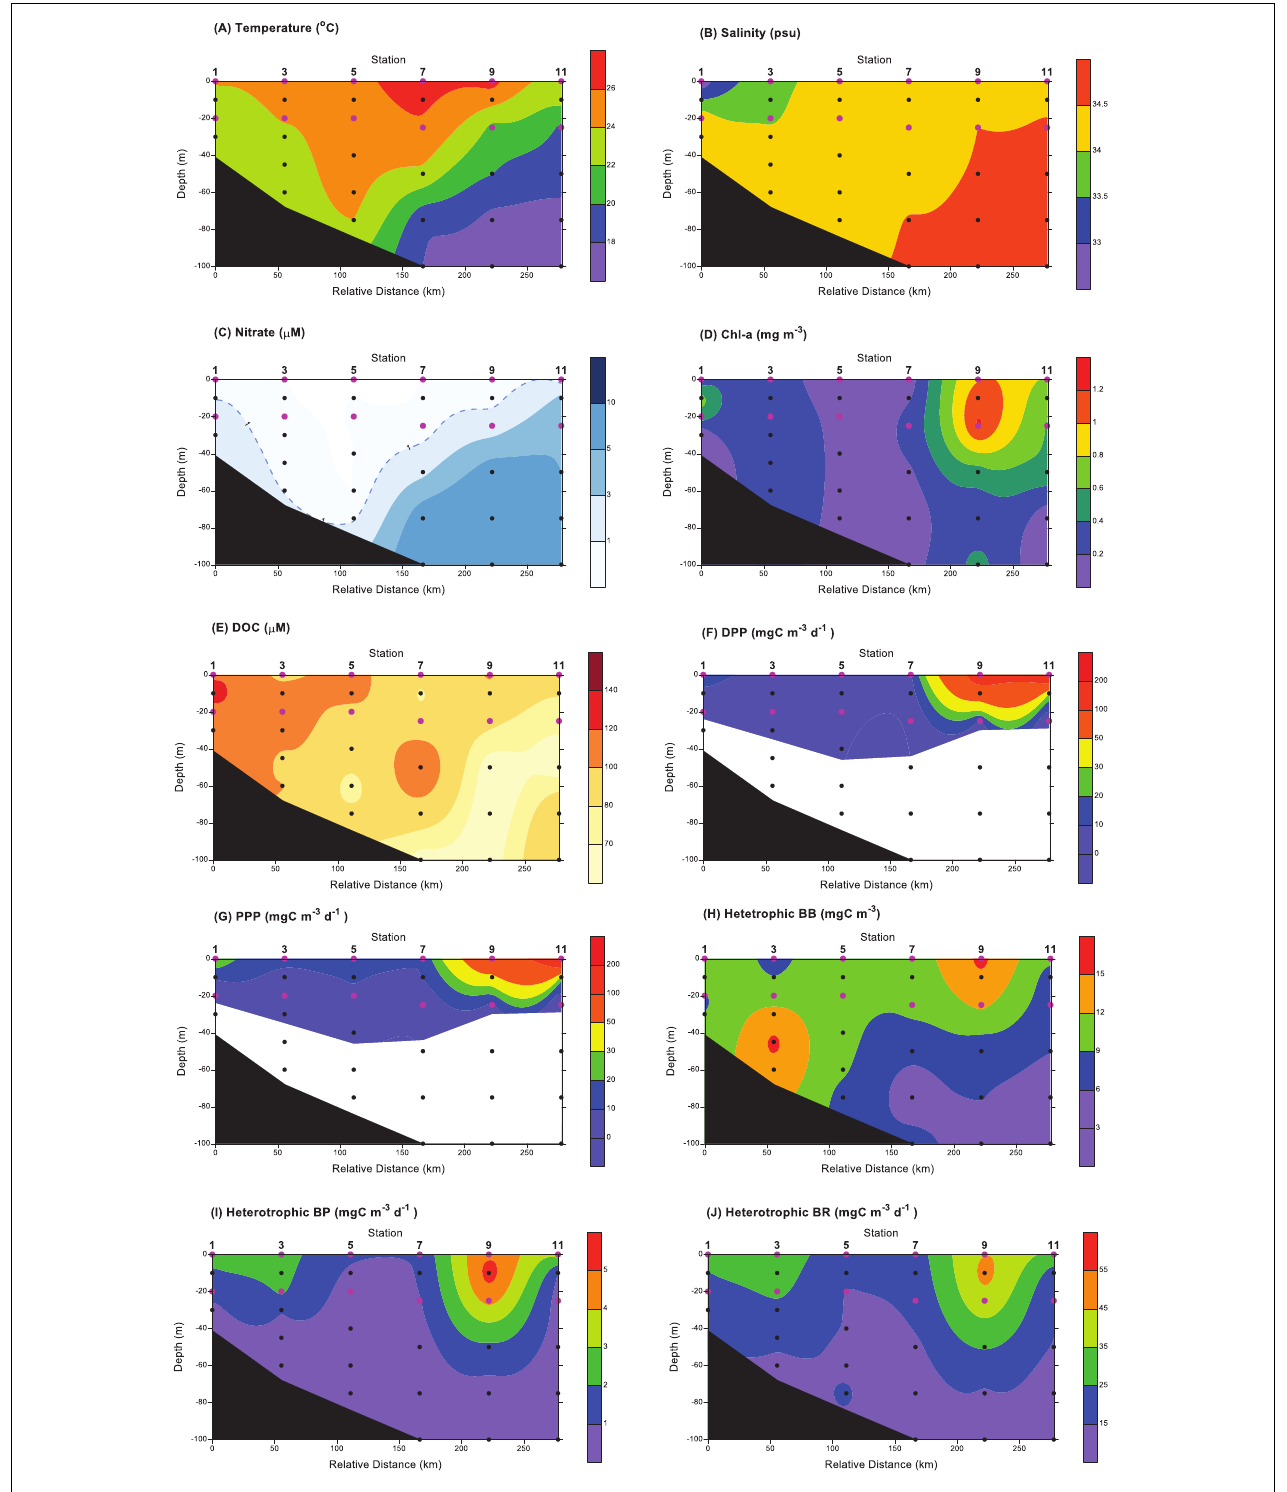
FIGURE 2 | Vertical distribution of (A) temperature; (B) salinity; (C) nitrate; (D) chlorophyll a ; (E) dissolved organic carbon (DOC); (F) dissolved primary production (DPP); (G) particulate primary production (PPP); (H) heterotrophic bacterial biomass(BB); (I) heterotrophic bacterial production (BP); (J) heterotrophic bacterial respiration (BR). DPP and PPP values were modeled from P B –E curves and BR values were derived from BP at the same depth as BR = 6.21*BP 0 . 56 ± 0 . 13 ( r 2 = 0.66; p < 0.01; n = 12). Black dots denoted sampling depths; and pink dots denoted where the photosynthesis-irradiance experiments and BR were performed.